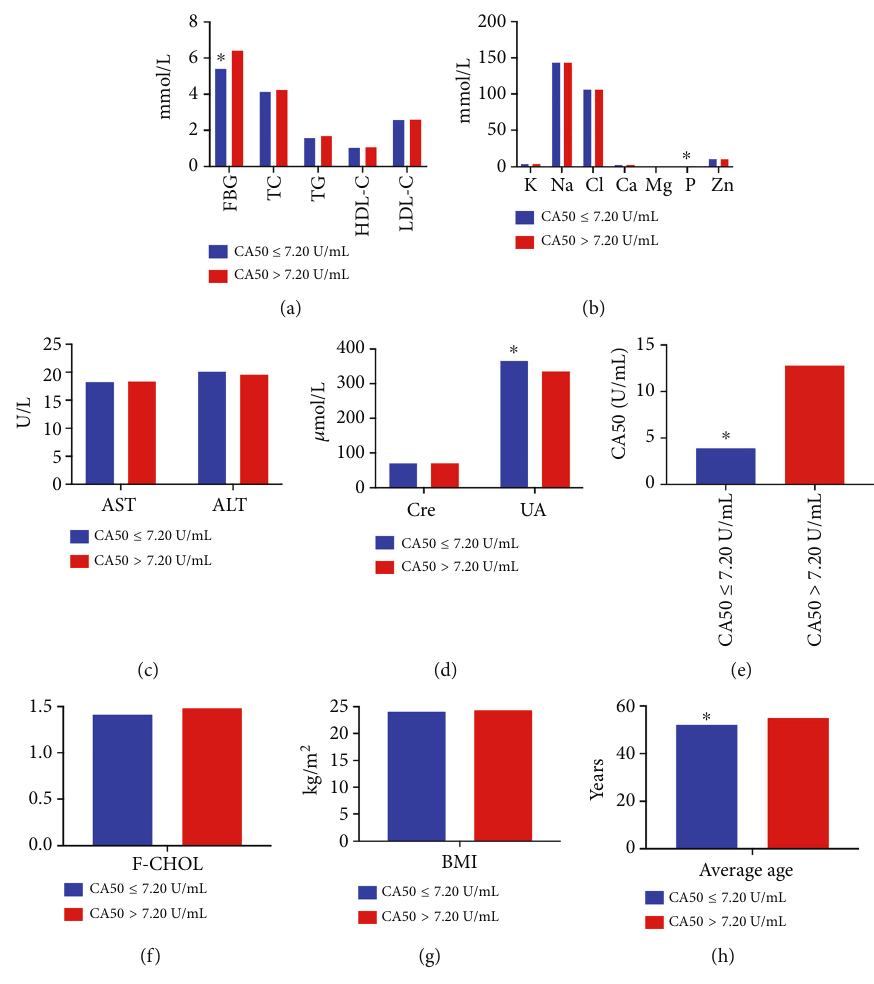
Figure 8: Comparison of di ff erent indicators between the CA50 ≤ 7 : 2U/mL and CA50 > 7 : 2 U/mL groups. (a) Comparison of levels of FBG, TC, TG, HDL-C, and LDL-C between the two groups. Compared with the CA50 > 7 : 2U/mL group, the levels of FBG were signi fi cantly lower in CA50 ≤ 7 : 2 U/mL group. (b) Comparison of levels of K, Na, Cl, Ca, Mg, P, and Zn in the blood between the two groups. (c) Comparison of AST and ALT levels between the groups. (d) Comparison of Cre and UA levels between the groups. The levels of UA in CA50 ≤ 7 : 2 U/mL group were signi fi cantly higher than that in CA50 > 7 : 2U/mL group. (e) The CA50 in CA50 ≤ 7 : 2U/mL group was signi fi cantly lower than that in CA50 > 7 : 2 U/mL group. (f) Comparison of F-CHOL between the groups. (g) Comparison of BMI of patients between the groups. (h) The average age of patients in CA50 ≤ 7 : 2 U/mL group was signi fi cantly lower than in CA50 > 7 : 2U/mL